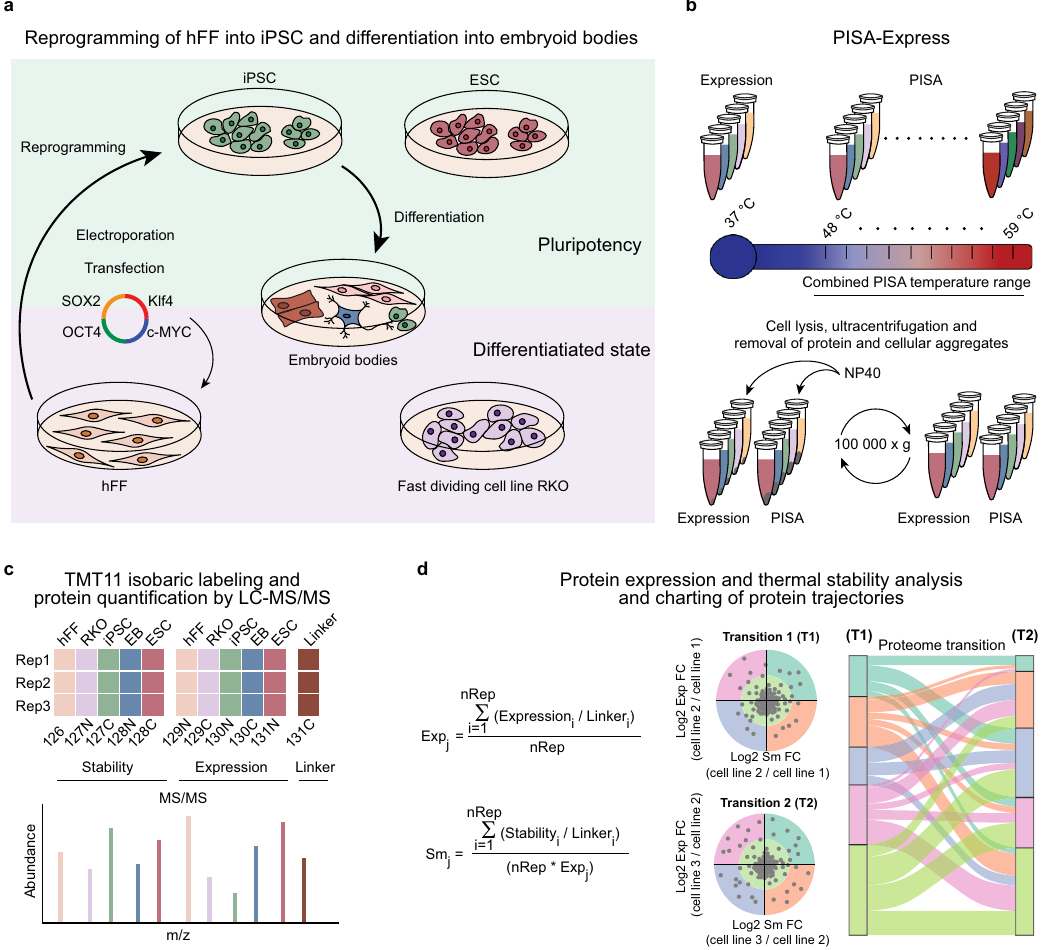
Fig. 1 Protein thermal stability and expression changes in cell-type transitions. a Cells of different types in were grown simultaneously ( n = 3 biologically independent samples per cell type). b Cells were collected and heated in a narrow temperature range, with one sample incubated at 37 °C for expression measurements, protein aggregates were eliminated by ultracentrifugation and the soluble proteins were digested. c 1/10 portions of each sample were integrated into a pooled sample and digests were labelled by TMT11 and multiplexed. d The same pooled sample was used in all multiplexed sets for normalization or reporter ion abundances PISA parameter (Sm) and expression fold change (Exp) were calculated, and protein trajectories during cell transitions were charted using a Sankey (Supplementary Fig. 4c, d). For each protein, fold changes (FCs) of Sm and Exp were calculated compared to those of the iPSC population, as well as the standard deviations of these values across the whole dataset. The mean standard deviations of Sm and Exp were also calculated for all proteins. The number of statistical outliers exhibiting more than three mean standard deviations was similar for both expression and stability (Fig. 2c).